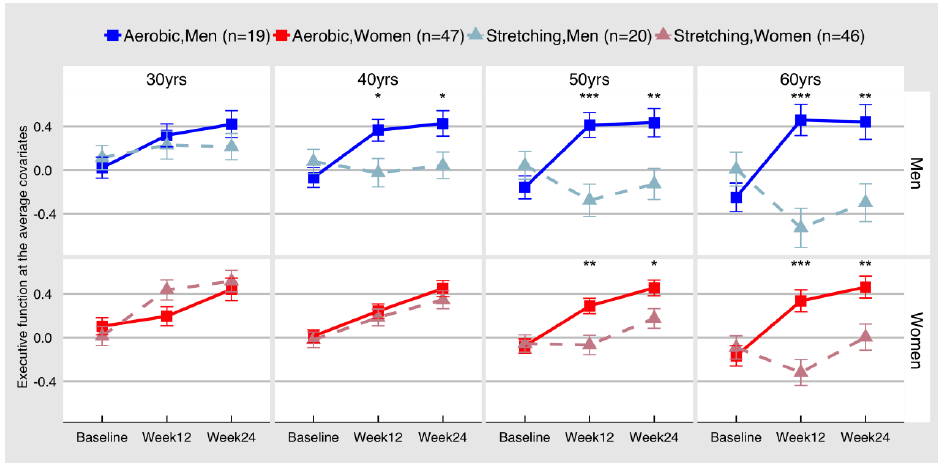
Figure 1. Change in executive function by condition, age and sex. Values are least squares means of fixed effects by age decades at the average IQ and years of education. There is significant age and sex moderation, such that older groups benefit from aerobic exercise more than young, and men benefit more than women. * p < 0.05; ** p < 0.01; *** p < 0.001